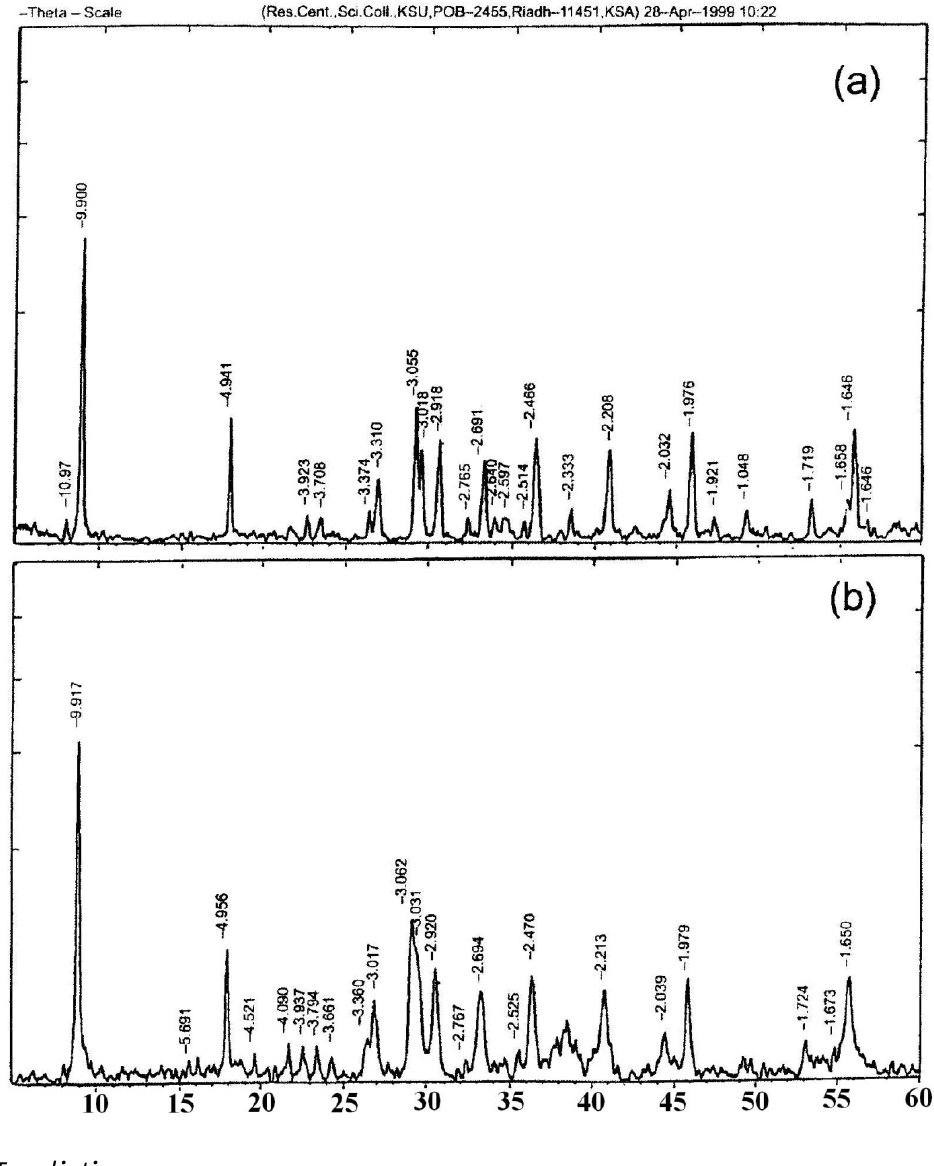
Figure 4. XRD for sliver acetate ( a ) un-irradiated and ( b ) γ -irradiated (10 3